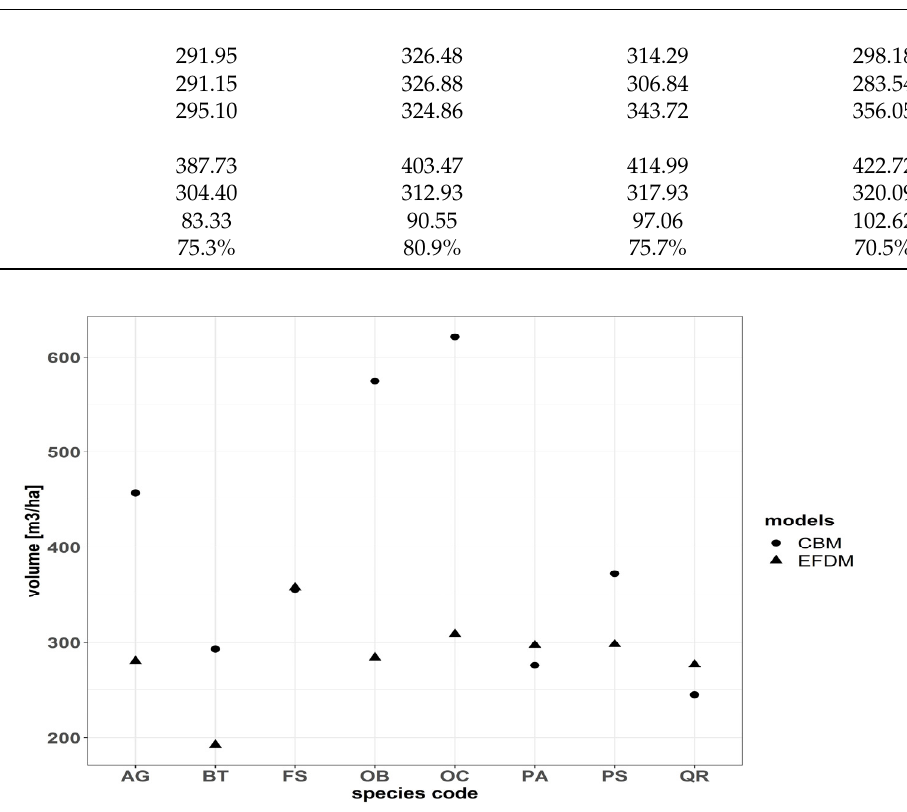
Figure 7. Growing stock volume (in 2030) by species, predicted by both models reported in m 3 *ha − 1 .